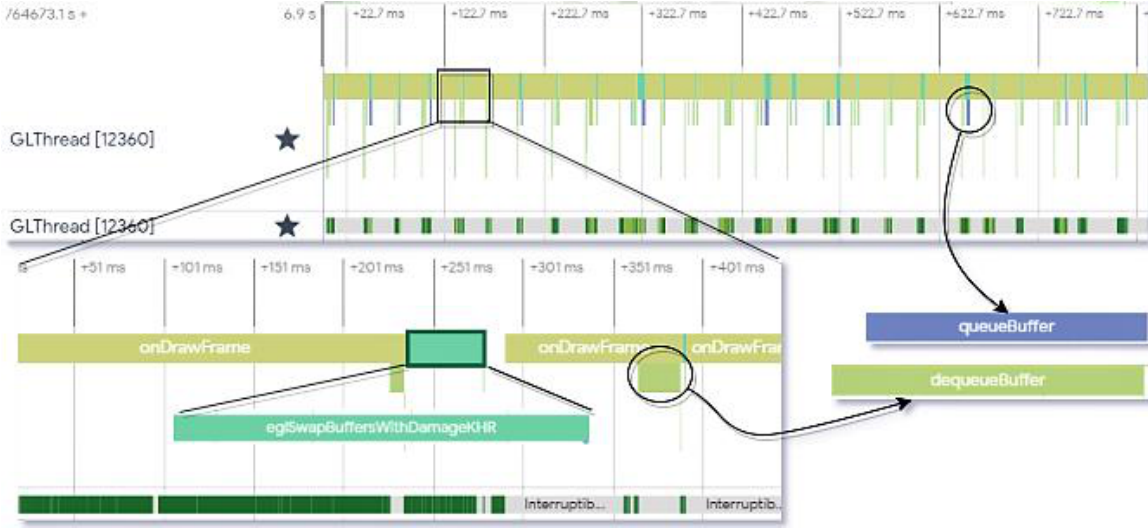
Figure 7. GLThread‘s process that represents the OpenGL commands used to draw the UI thread. Crossing frame boundaries and long onDrawFrame procedures can be noticed. The SwapBuffersWithDamageKHR represents the content that must be recomposed.